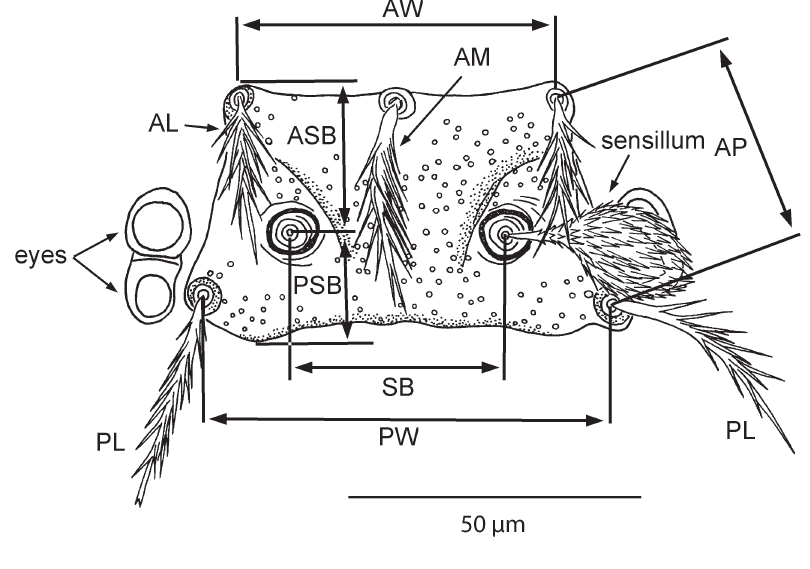
Fig. 1. Scutum of an example of Schoutedenichia